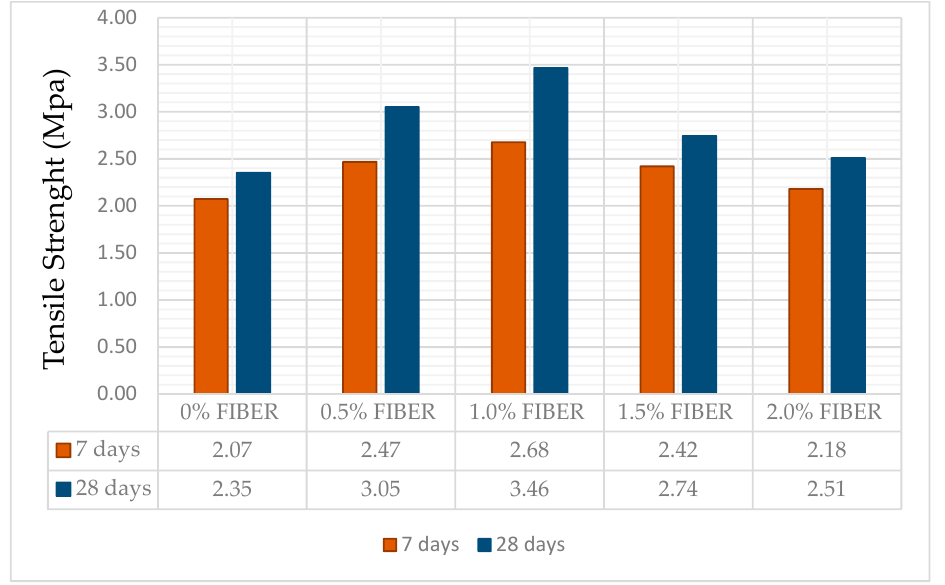
Figure 7. Split tensile strength of sisal fiber reinforced-concrete.